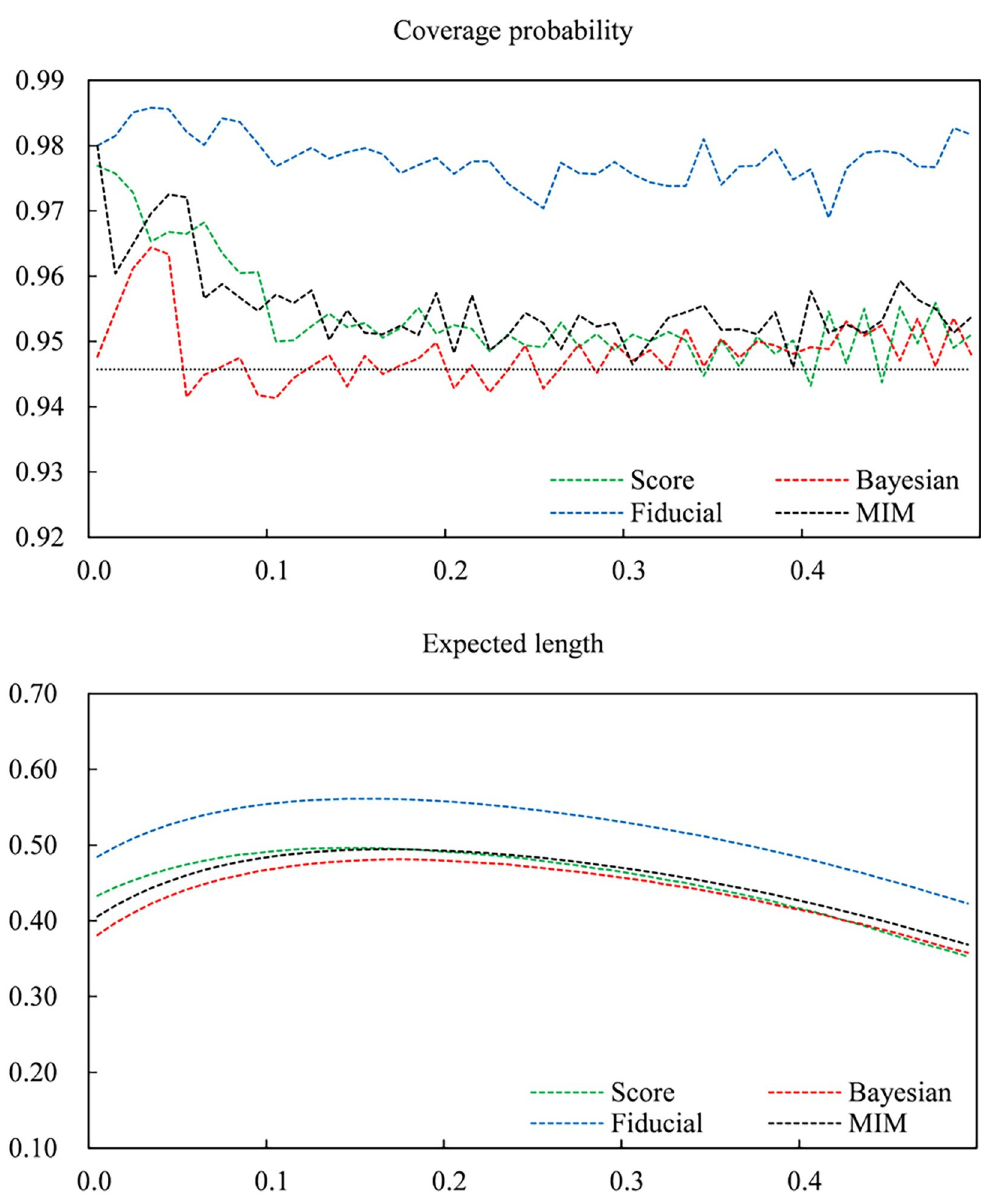
Fig 3. Coverage probabilities and expected lengths of the Score, Bayes, fiducial and MIM confidence intervals versus P 12 for fixed P 11 , where n = 30 and P 11 =